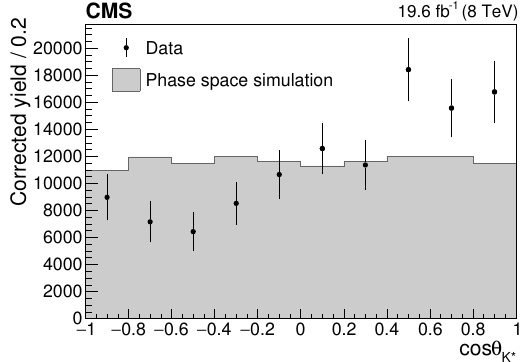
Figure 4 . The background-subtracted and e(cid:14)ciency-corrected cos (cid:18) (points with vertical bars) and the phase space simulation (shaded histogram). The vertical bars represent the statistical